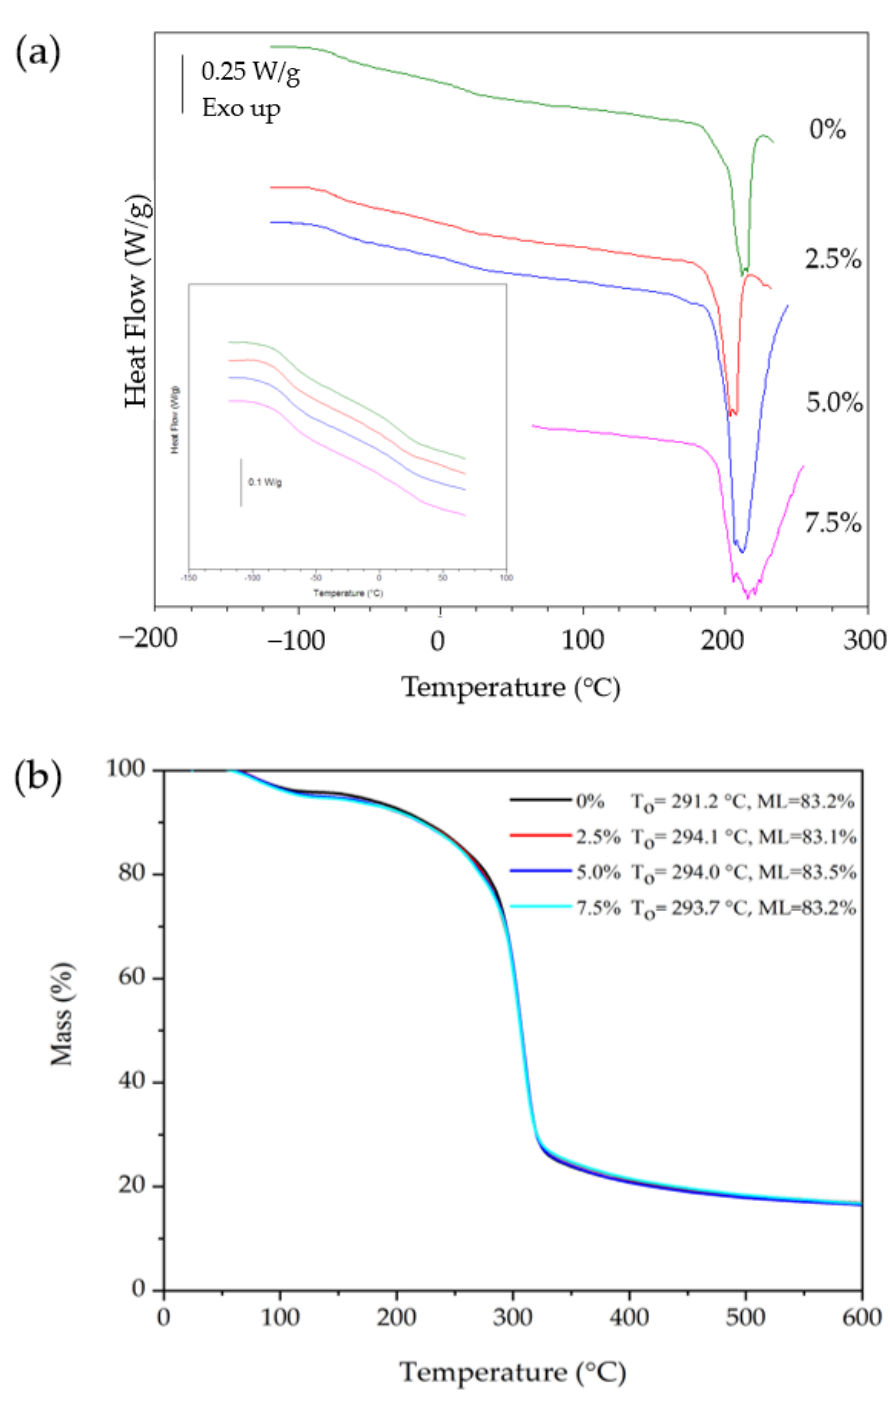
Figure 6. ( a ) Differential scanning calorimetric curves and ( b ) thermogravimetric curves of cassava starch films with quinoa starch nanocrystals at different concentrations. T 0 = onset decomposition temperature, ML = mass loss. Table 3. Cassava film thermal properties with quinoa starch nanocrystals (QSNC) at different con- centrations *.